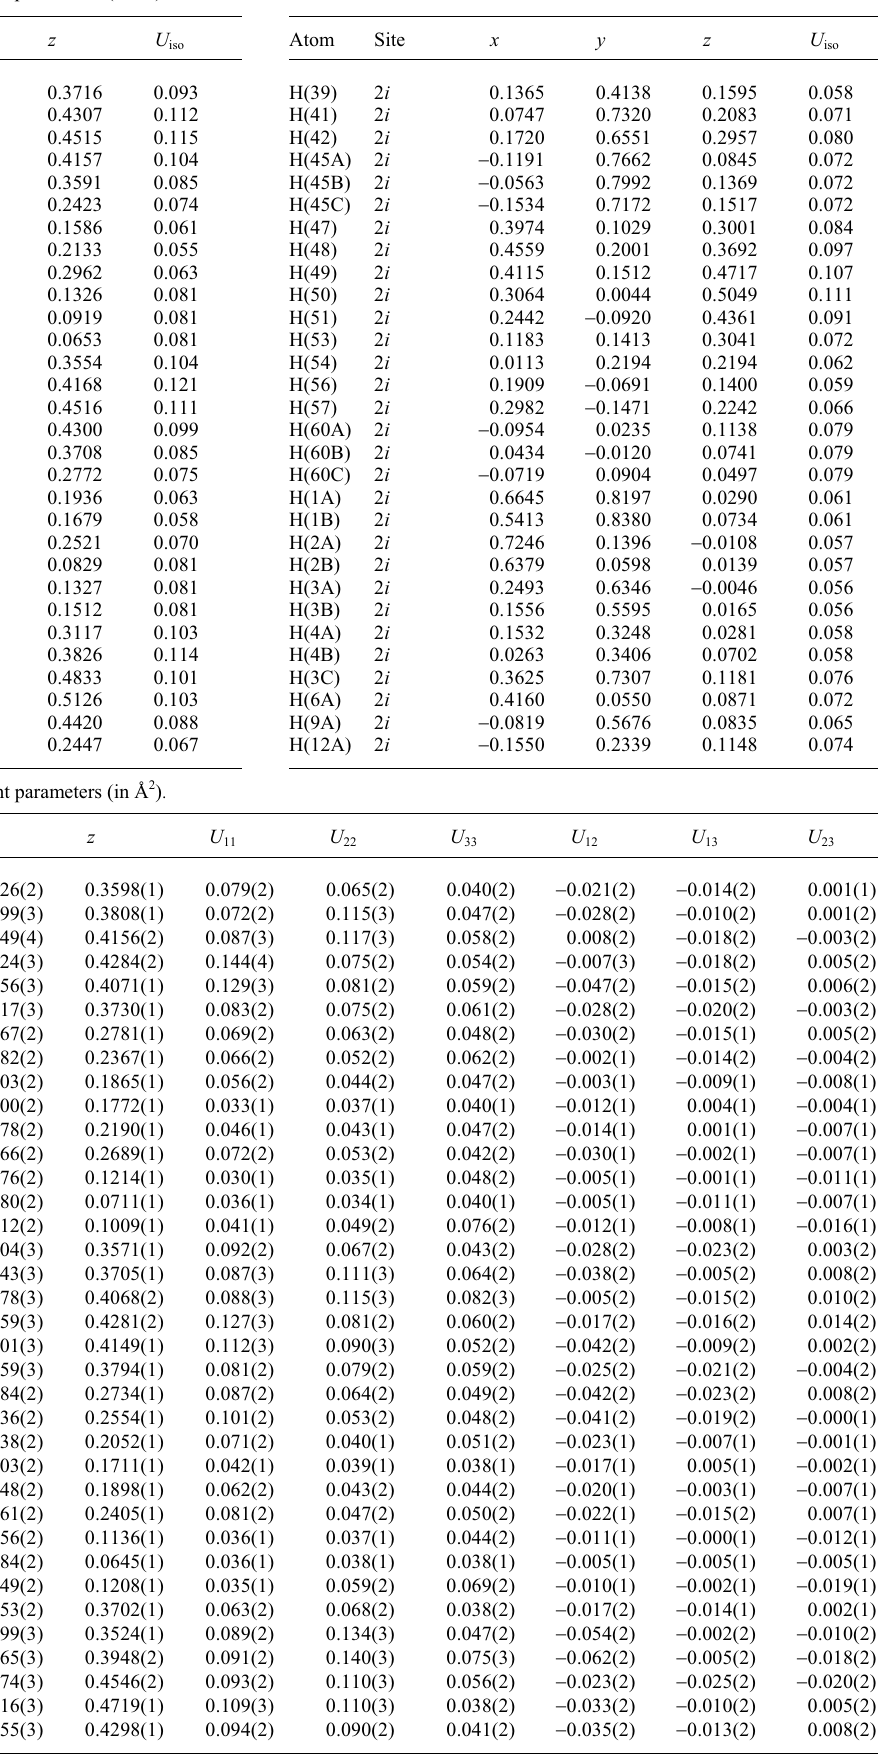
Table 2. Atomic coordinates and displacement parameters (in Å 2 ) .